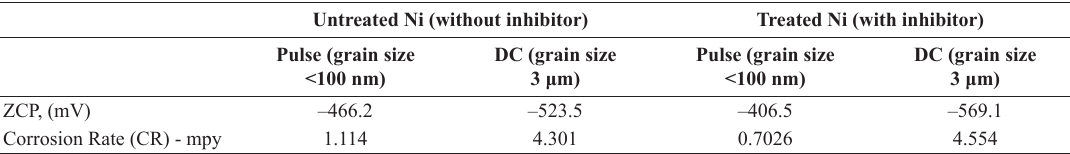
Figure 4. Potentiodynamic polarization (Tafel) plots obtained for coarse and fine Ni deposited on untreated and inhibitor treated carbon Table 1. Electrochemical measurements obtained from potentiodynamic polarization plots for untreated and inhibitor treated Ni electrodeposits.